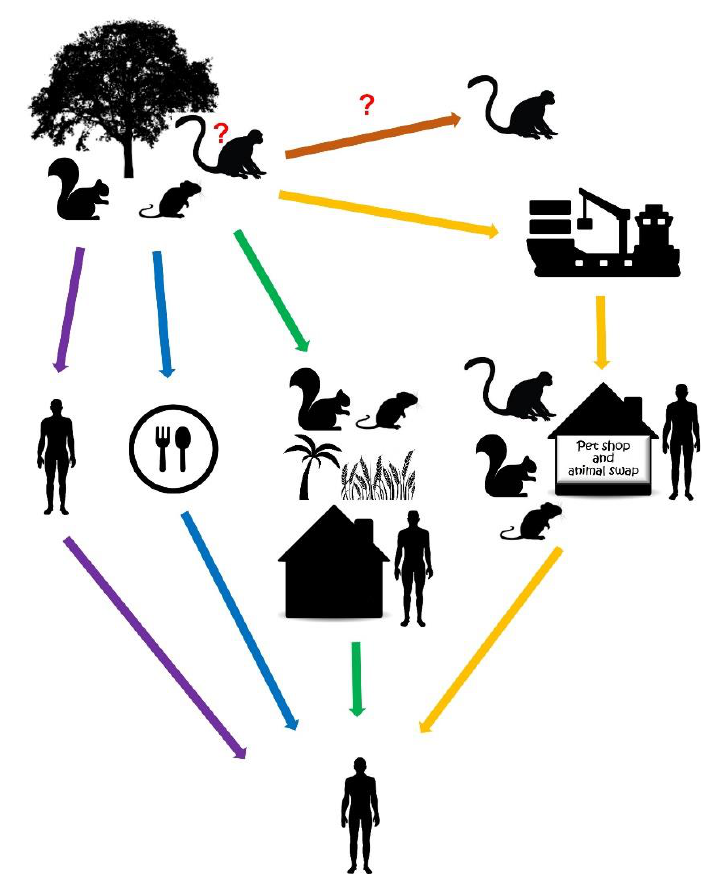
Figure 2. Potential transmission routes of monkeypox virus. Rodents have been suggested as natural hosts of MPXV that may transmit the virus to the human environment (green arrow). Close contact with the animals (green arrow) and with infected humans (purple arrow), consumption (blue arrow) and wild animal trade (yellow arrow) pose a risk to species spillover and zoonotic MPXV infection. Although non-human primates may be reservoirs of the virus, accidental infection of this group of animals is conceivable (orange arrow).